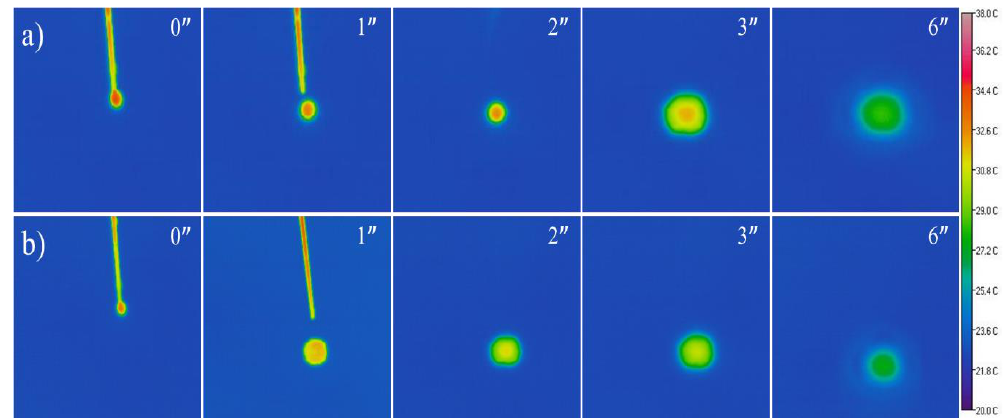
Figure 5. IR thermography images to show temperature change when dropping 37 °C water on a directional water transport fabric: ( a ) On the SU-8 sprayed surface; and ( b ) On the unsprayed back surface (Ambient temperature 23 ± 1 °C).